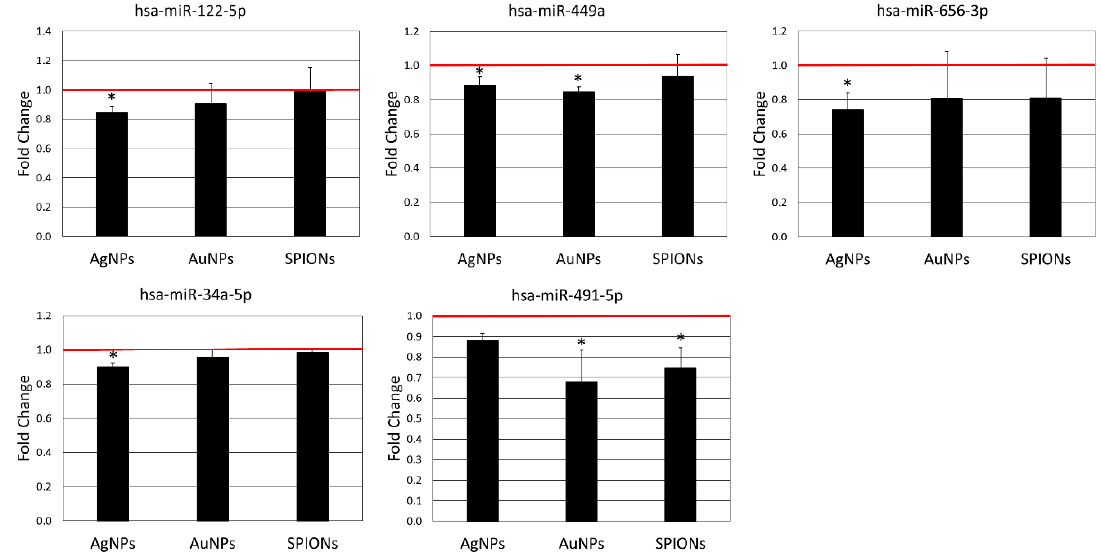
Figure 2. Expression of miRNAs down-regulated by AgNPs (10 µg/mL), AuNPs (10 µg/mL) or SPIONs (5 µg/mL) treatment for 6 h. Data are expressed as the mean ± standard deviation from three independent experiments. The red line shows the expression level in the control group. Asterisks denote a statistically significant difference versus the control group.